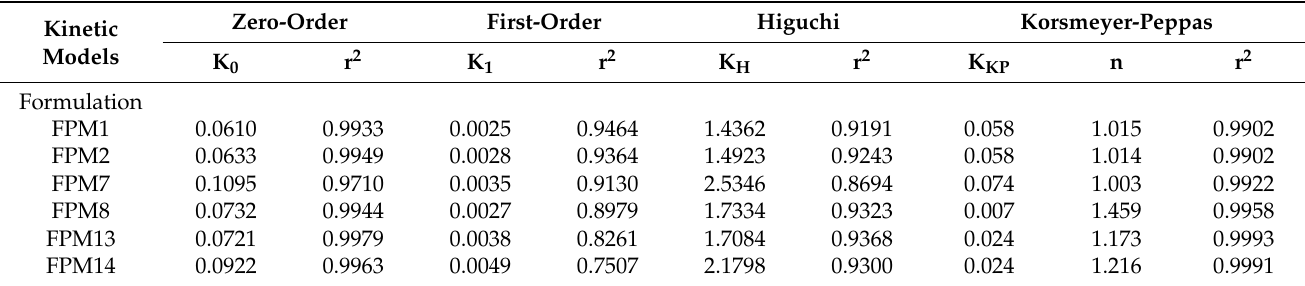
Table 3. Drug release over 8 h according to zero-order, first-order, Higuchi, and Korsmeyer-Peppas release kinetic